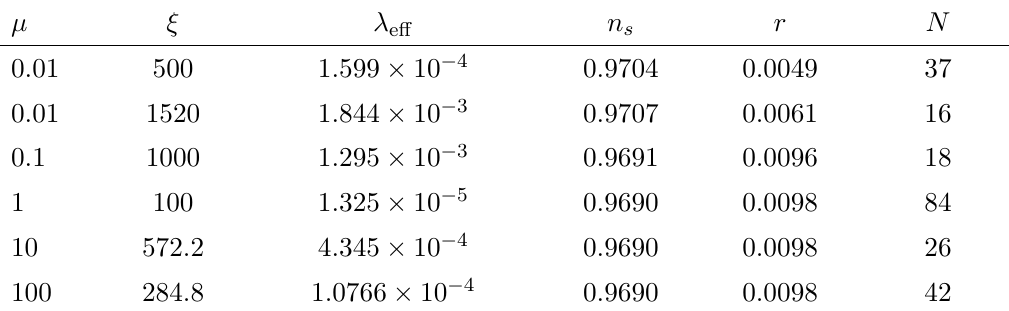
and tensor-to-scalar S